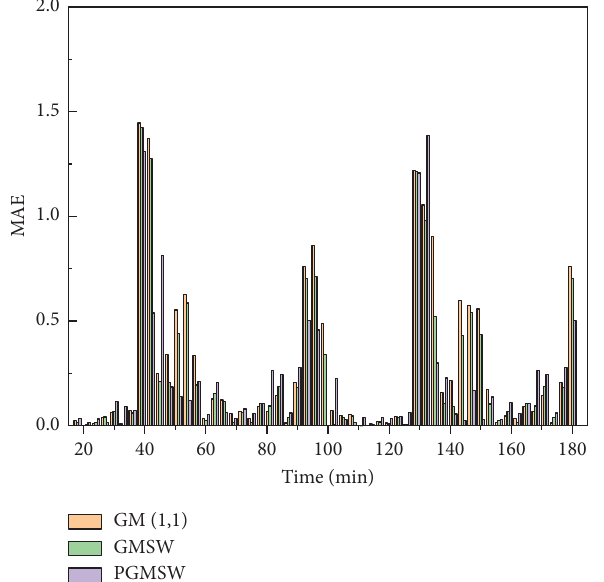
Figure 7: MAEs of the three models (window size � 1).